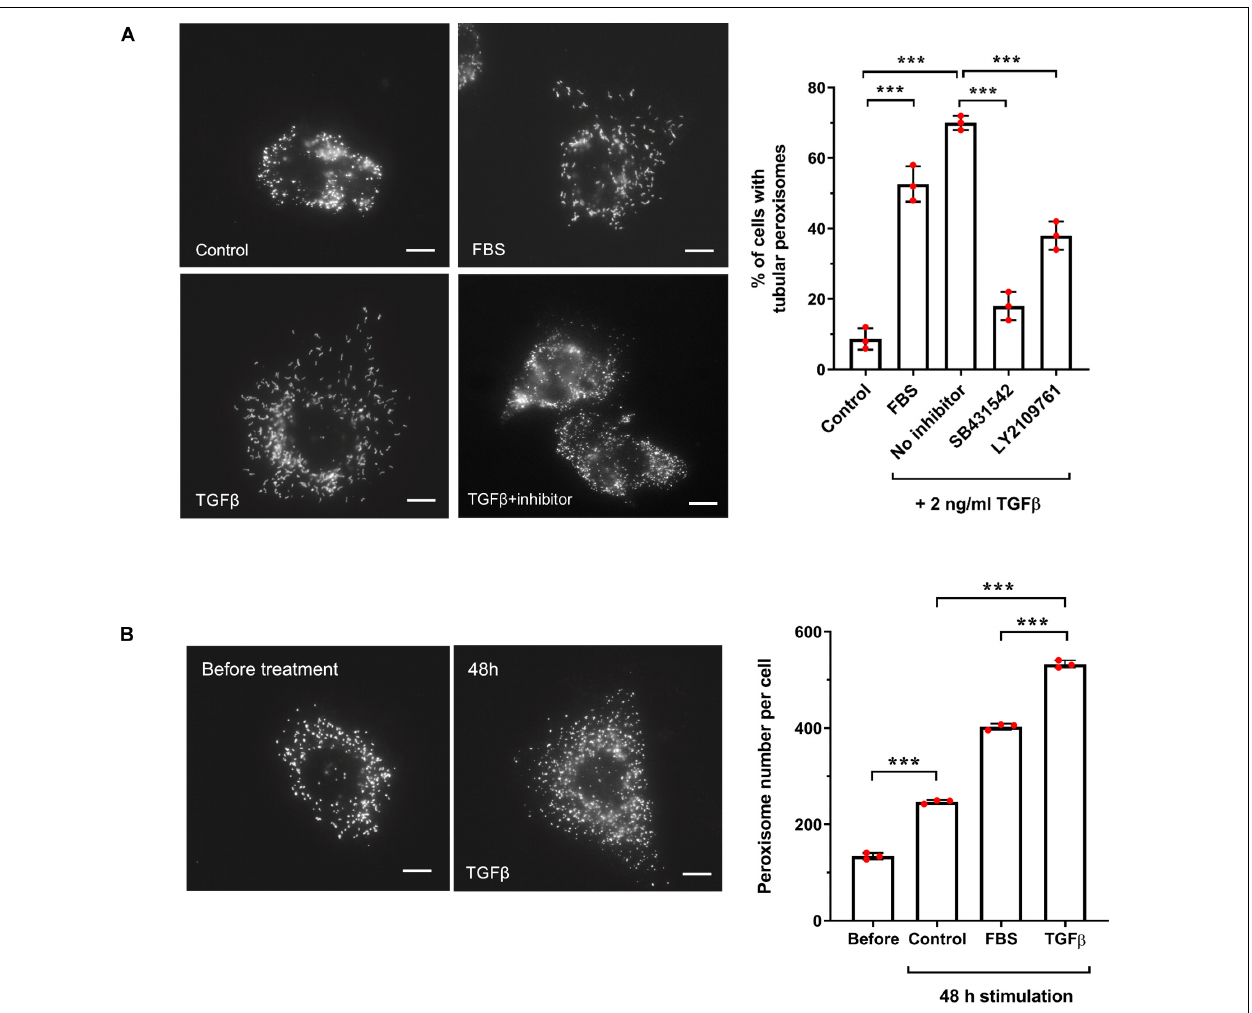
FIGURE 7 | TGF β increases peroxisome elongation and number in HepG2 cells. (A) HepG2 cells were cultured in MEM/N1, treated with 10% FBS, or TGF β (2 ng/ml) (with or without inhibitors LY2109761 or SB431542) or mock treated and processed for immunofluorescence after 24 h after treatment using anti-PEX14 antibodies. Representative images and quantitative analysis of peroxisome morphology (elongation) for the conditions described are shown. Data from 3 independent experiments ( n = 300 cells for each condition); analyzed by one-way ANOVA with Tukey’s post hoc test; *** p < 0.001. Bars, 10 µ m. (B) HepG2 cells were cultured in MEM/N1 for 6 h prior to the addition of TGF β (2 ng/ml) or 10% FBS, and processed for immunofluorescence after 6 h (‘before’ treatment) and 48 h after treatment as described in (A) . Representative images and quantitative analysis of peroxisome number/cell before and 48 h are shown. Data from 3 independent experiments ( n = 10 cells for each condition); analyzed by one-way ANOVA with Tukey’s post hoc test; *** p < 0.001. Bars, 10 µ